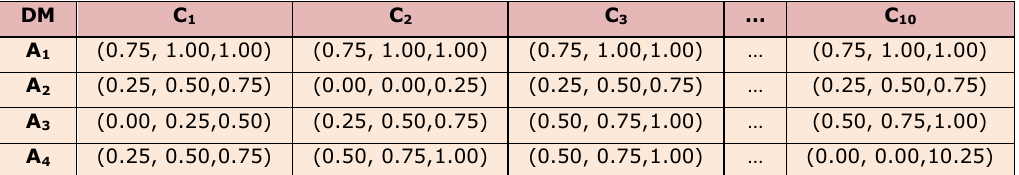
Table 2. Aggregate decision matrix for fuzzy Shannon’s